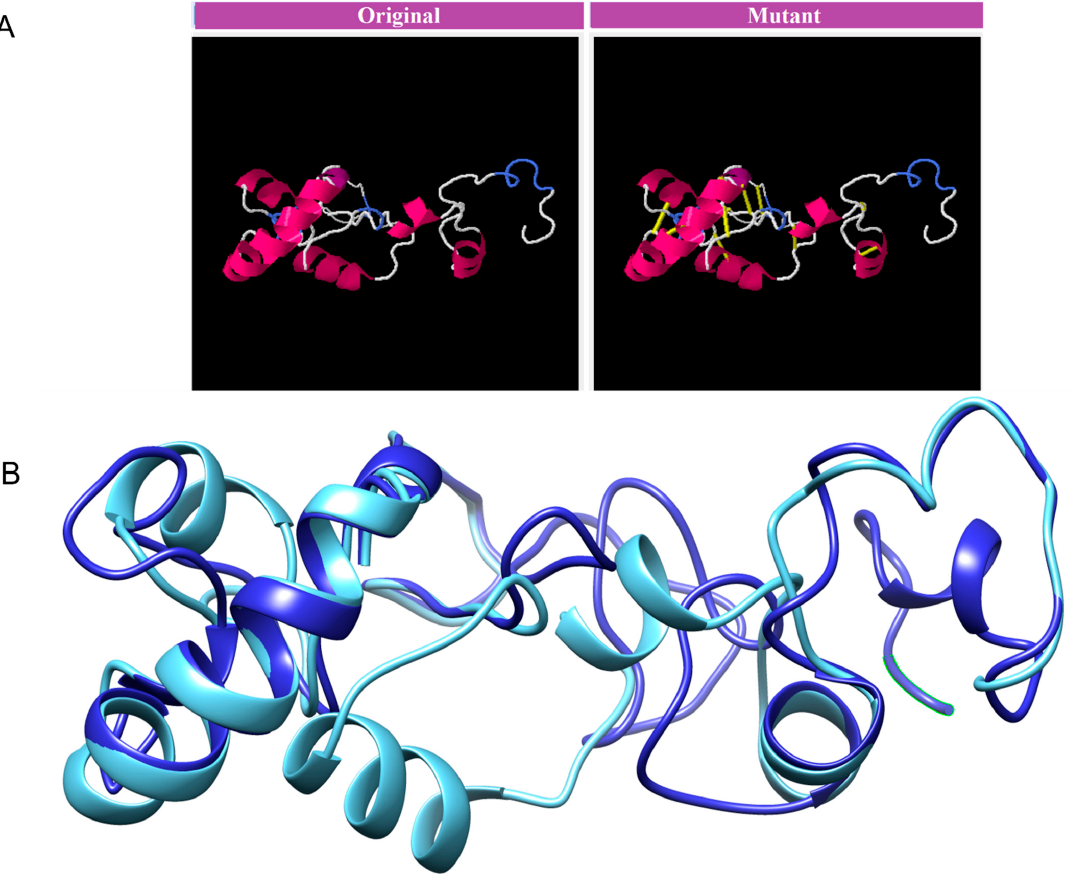
Figure 5. The original and mutant disulphide structures of vaccine construct ( A ). Superimposed model for the vaccine model and its mutant ( B ).